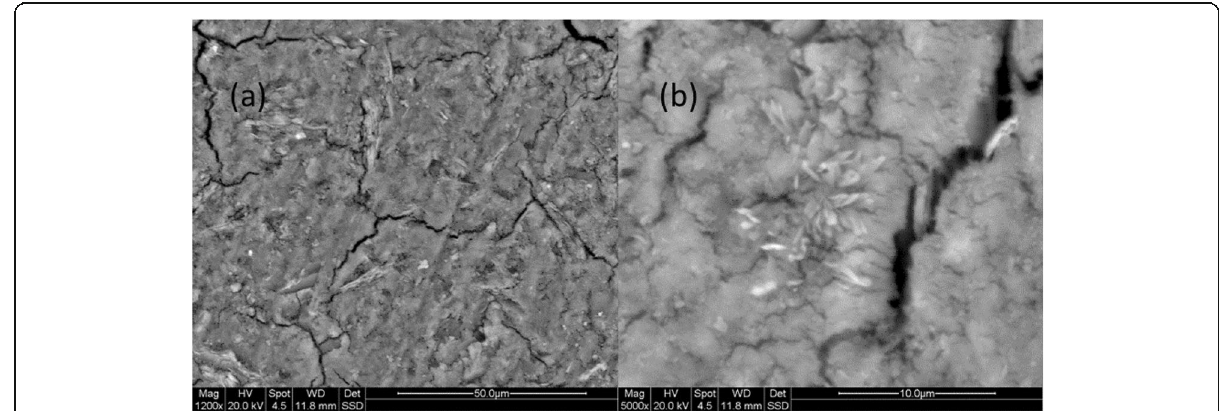
Fig. 2 SEM results reporting the BSE image of a freshly fractured geopolymer (MTWC) surface at different magnifications: a 1200x and b